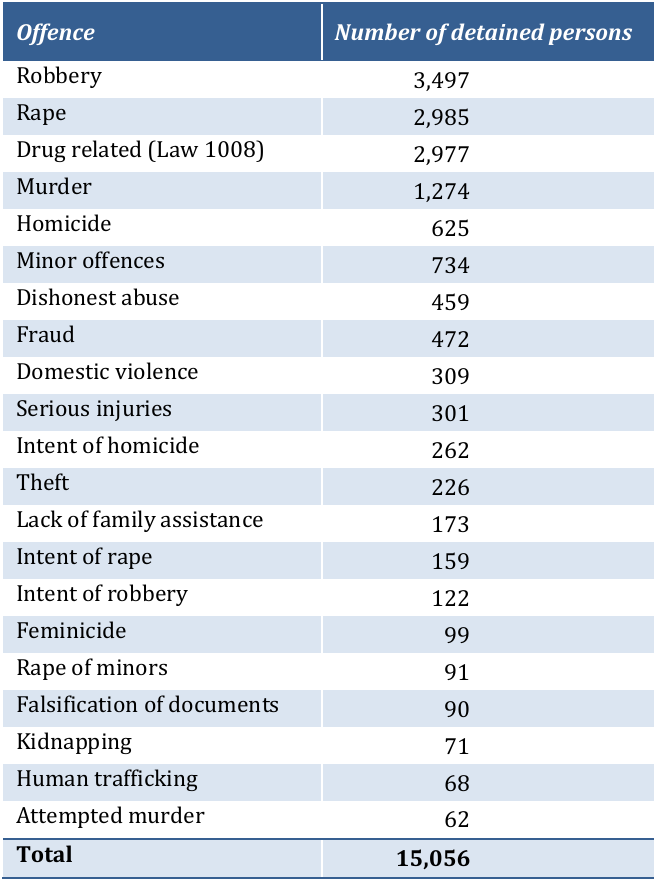
Table 4: Incarceration according to crime committed/accusation, 2016